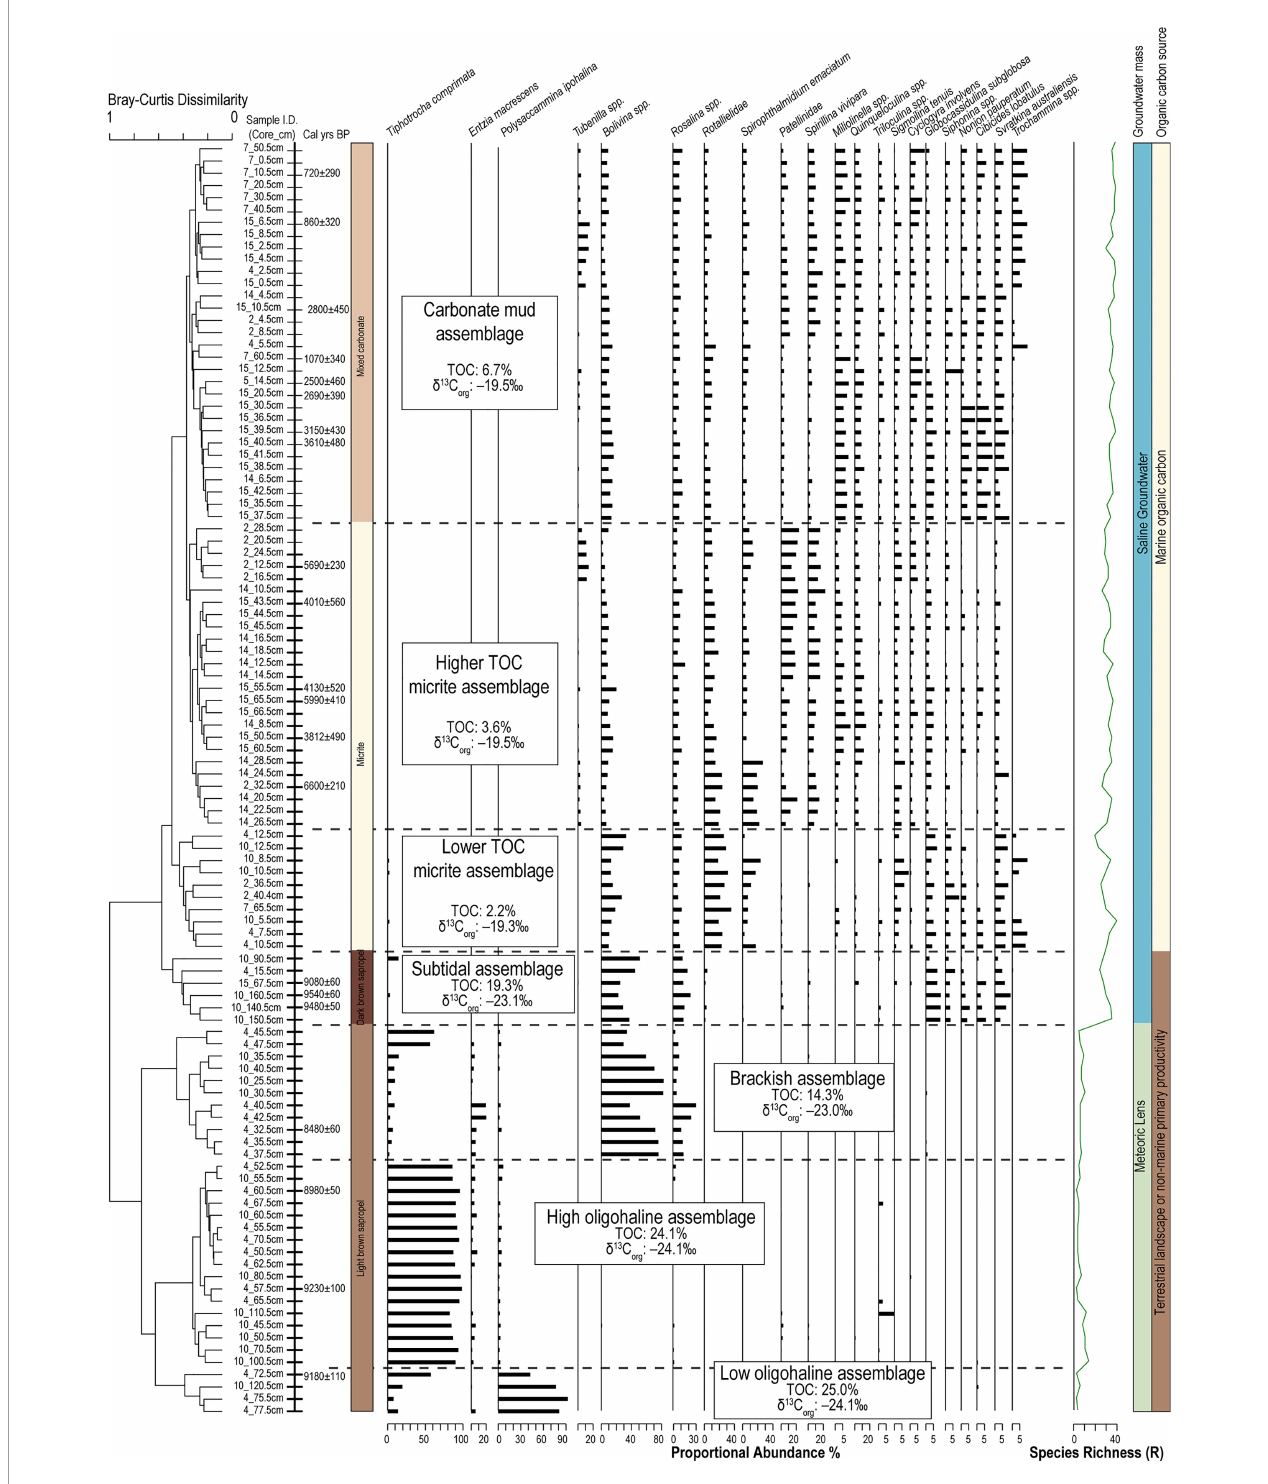
FIGURE 5 | Dendrogram produced from unconstrained Q-mode cluster analysis groups samples into 7 discrete assemblages (Bray-Curtis dissimilarity 0.55) that can be attributed primarily to inferred groundwater masses (Meteoric lens vs. saline groundwater), and secondarily by source and quantity of particulate organic carbon (POC). Only taxa with >5% in at least one sample are shown to emphasize signi fi cant